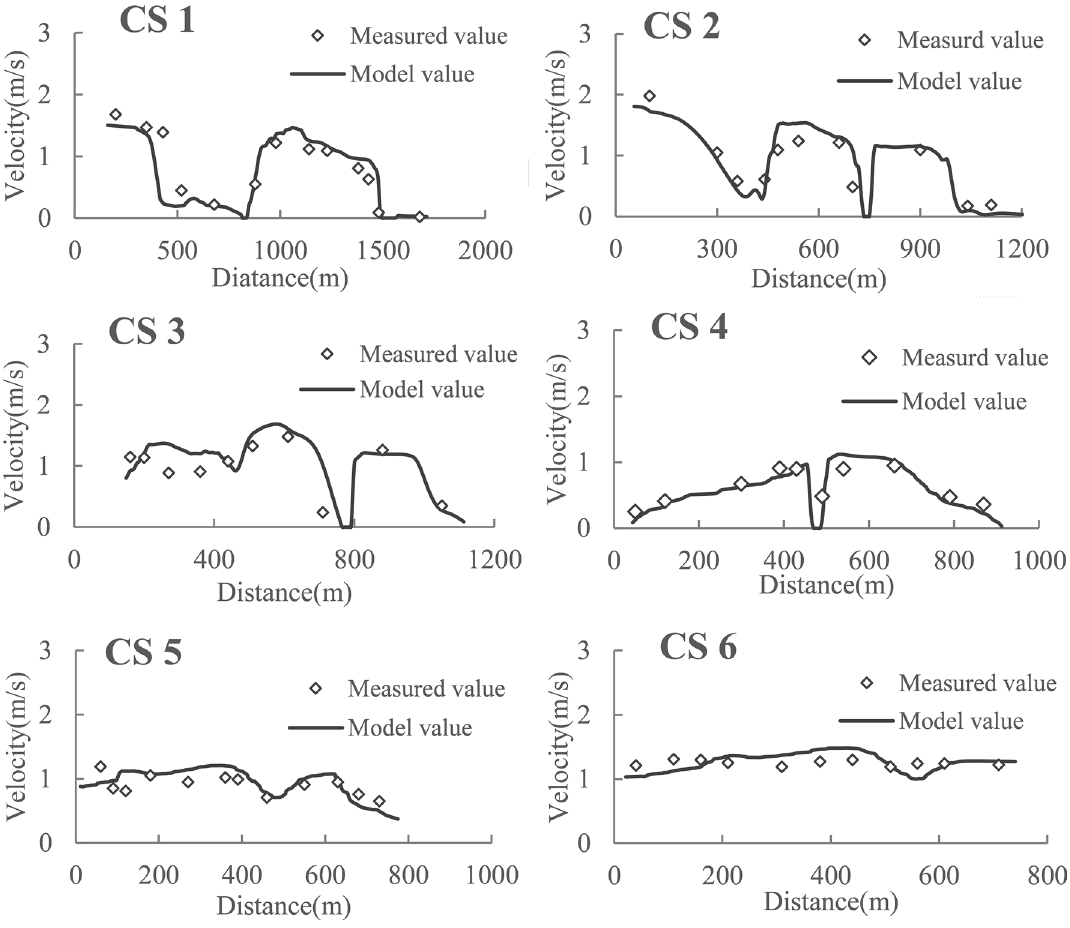
Figure 10. Plots of the measured and model values for cross-sections 1–6 (Fig.